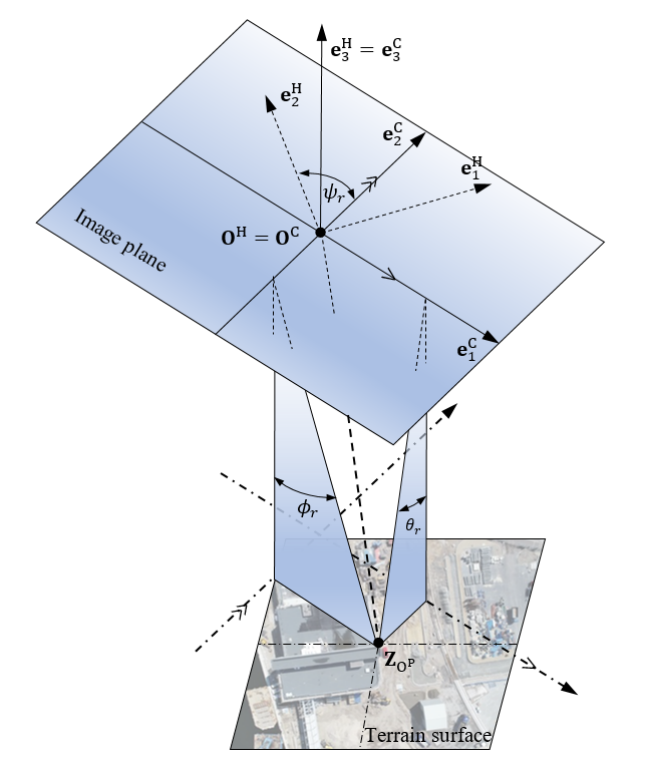
Figure 8. The idea of determining the angles of spatial orientation θ r , φ r